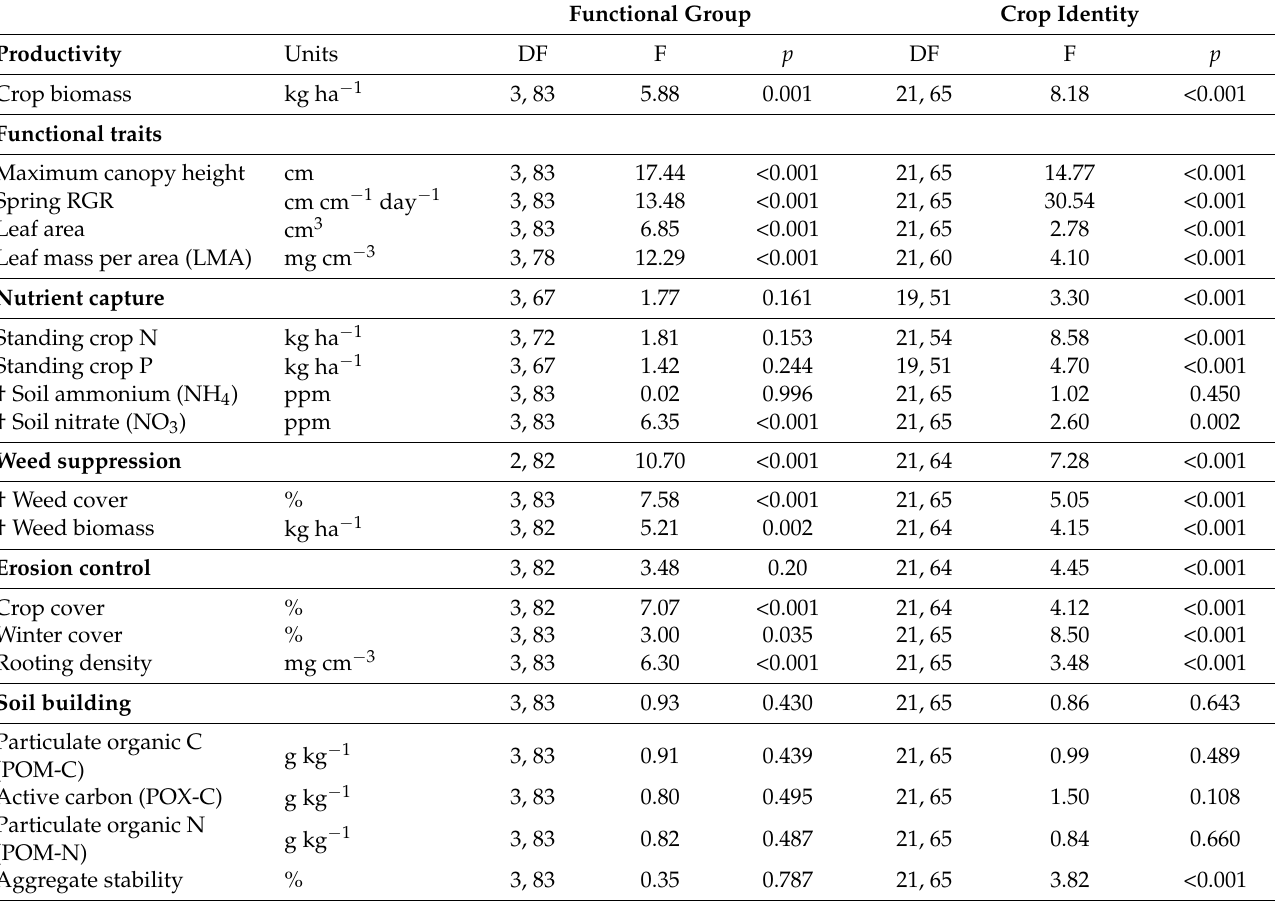
Table 2. Above and belowground responses of crops, weeds and soil attributes grouped by ecosystem service (in bold). † Measures that are inversely related to the agroecosystem service (e.g., less weed cover and biomass is greater weed suppression). Note rooting traits are not listed in the crop functional traits as they are under the ecosystem service erosion control. ANOVA results for the effect of crop functional group and identity are provided. Functional